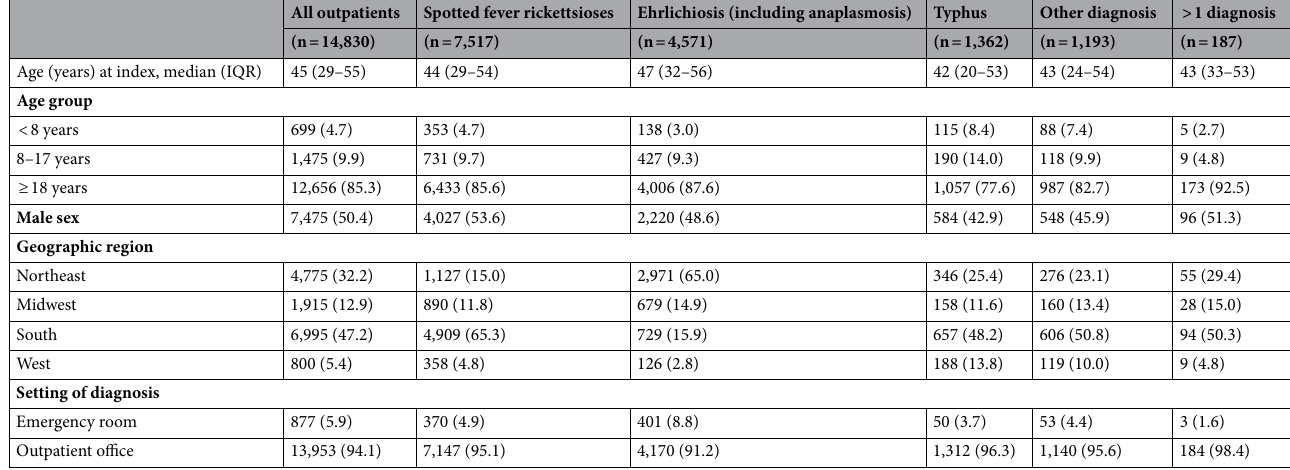
Table 1. Characteristics of outpatients diagnosed with rickettsial diseases in a large, commercially insured population—United States, 2005–2017. Data are presented as No. (%) unless otherwise indicated.